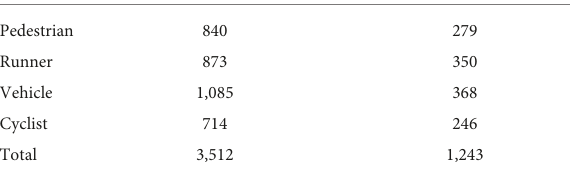
TABLE 3 Experimental results on different methods.